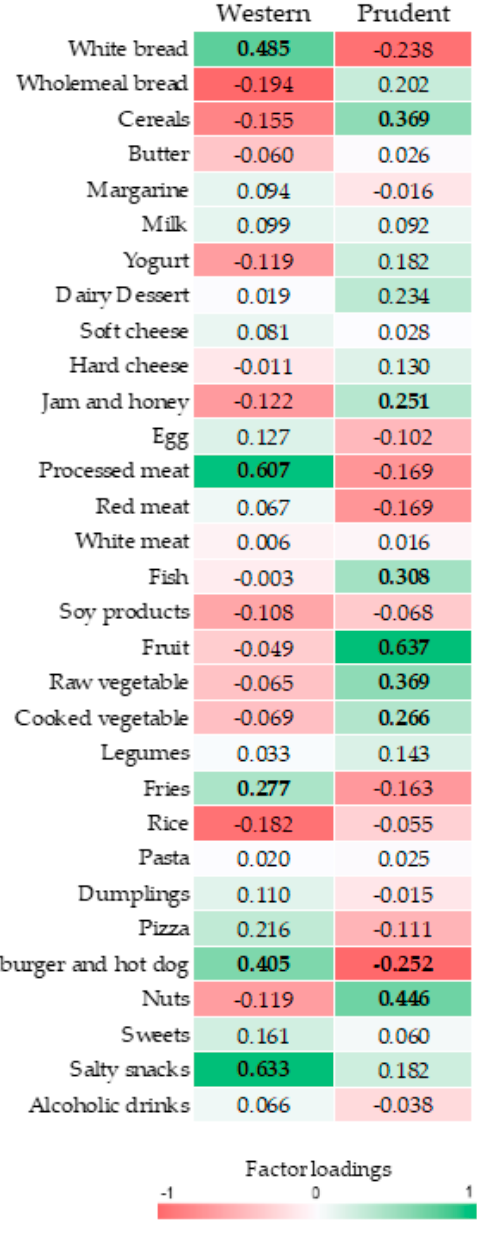
Figure 2. Table of factor loadings characterizing each dietary pattern. Food groups that negatively characterize the dietary patterns are indicated in red. Food groups that positively characterize the dietary patterns are indicated in green. Factor loadings ≥ |0.25|are in bold font.